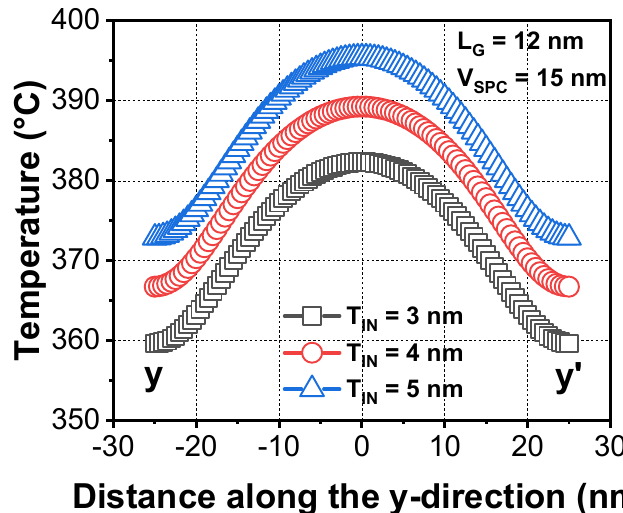
Figure 5. Extracted temperature during the ETA with various inner spacer thickness (T IN ).